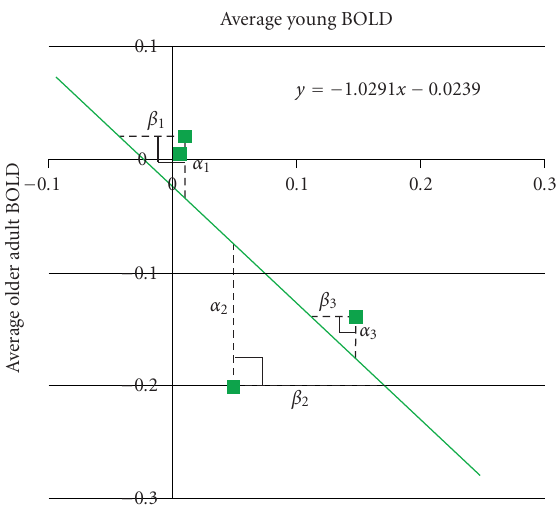
Figure 1: Representative voxel illustrating testing of the null hy- pothesis (H 0 : m = 1). To assess whether the null hypothesis is true in any given voxel, a t-test comparison of the α and β residual val- ues was used. When α (cid:2)= β , then the line was not significantly close to one and the voxel was considered to have a significant deviant slope. If the T value survived the correction for multiple compari- son (3 contiguous voxels where FWE P < .05), the respective brain area was considered to be a loci for general cognitive slowing. A sec- ond analysis is needed to identify areas where voxels with slopes of − 1 were eliminated in the residual analysis.